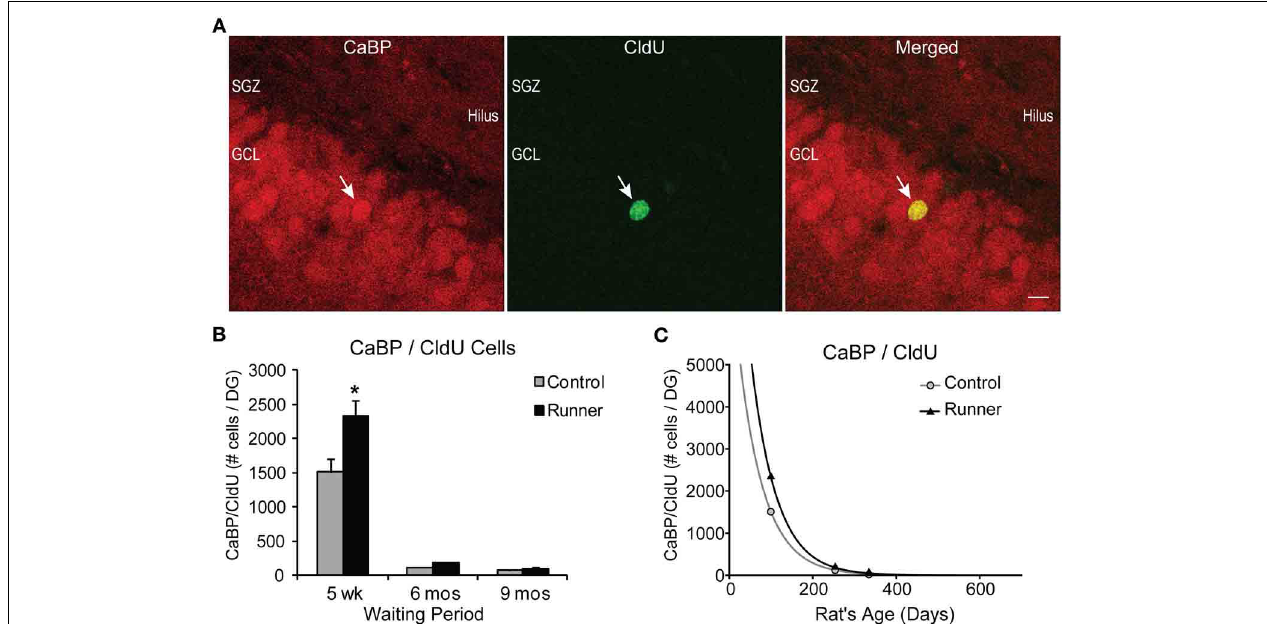
FIGURE 5 | Survival and neuronal maturation. (A) Confocal microscopic images (40 × , 1 μ m thickness) showing CaBP and CldU-labeled cells in the GCL. White arrow indicates dual-labeled CaBP/CldU cell in the GCL. Scale bar, 10um. (B) Number (mean ± s.e.m.) of dual-labeled cells per DG. Runners in the 5 week cohort (14 weeks of age) showed significantly more dual-labeled